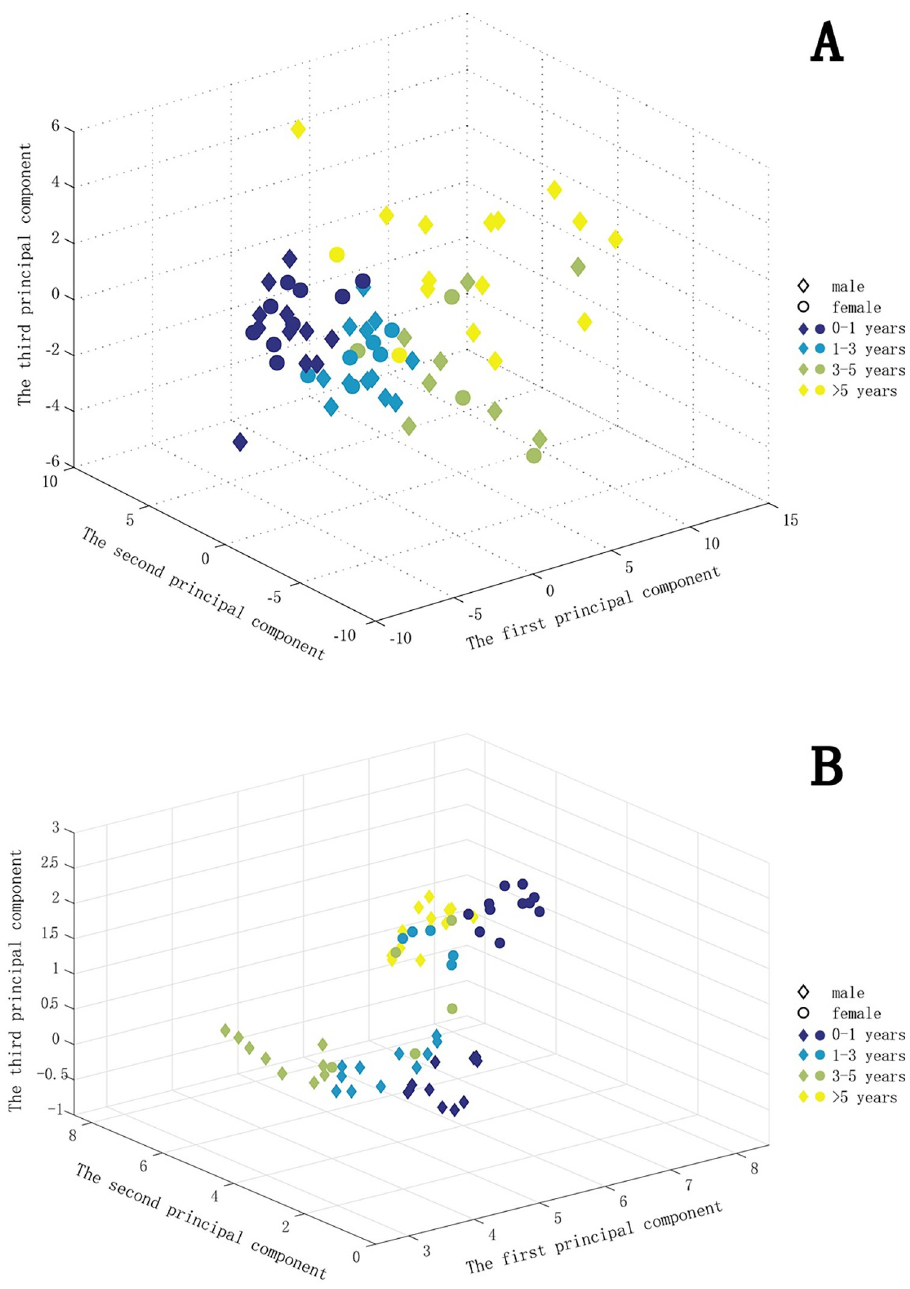
Fig 3. Clustering and visualization of physiological features along the axes of gender and age groups. Each data point represents a vector of a subjects’ HR, ACC, GSR and GYR data. (A) Clustering by Principal Component Analysis (PCA), (B) Clustering results after applying UMAP (Uniform Manifold Approximation and Projection). 2. R-R Interval statistics (10): Maximum, Minimum, Mean, Median, Standard deviation, Q1 (25% Quartile), Q3 (75% Quartile), 10 percentile point, 90 percentile point and Peak value difference.